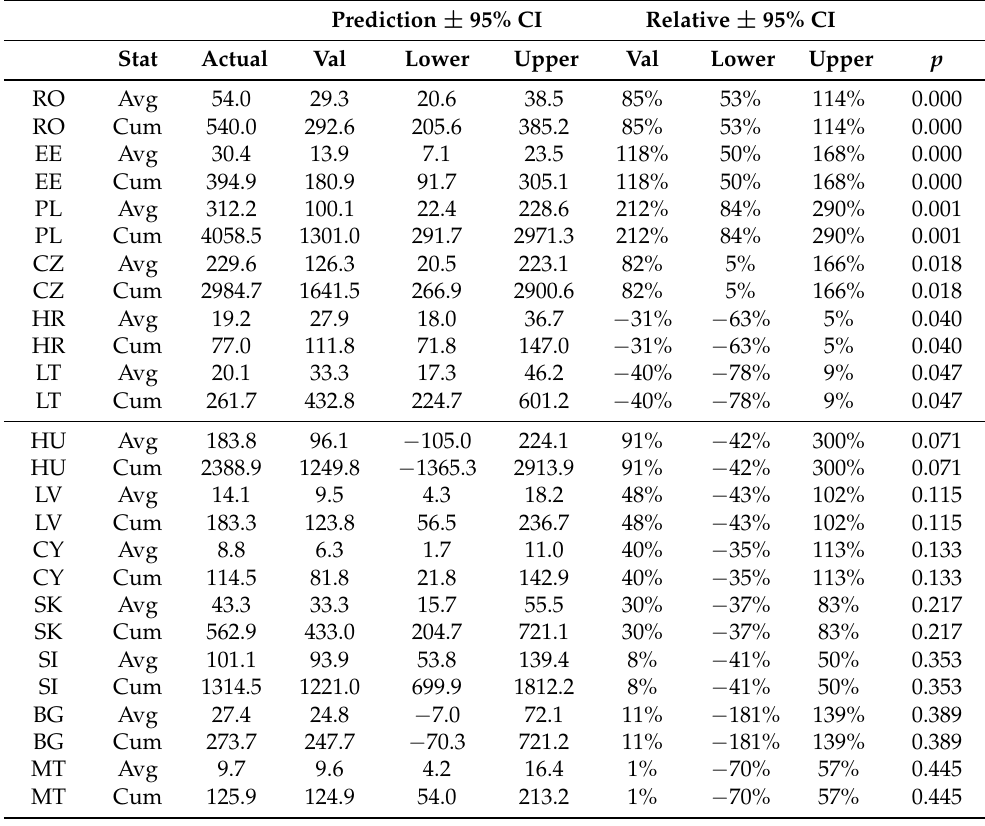
Table 1. Summaries of causal impact